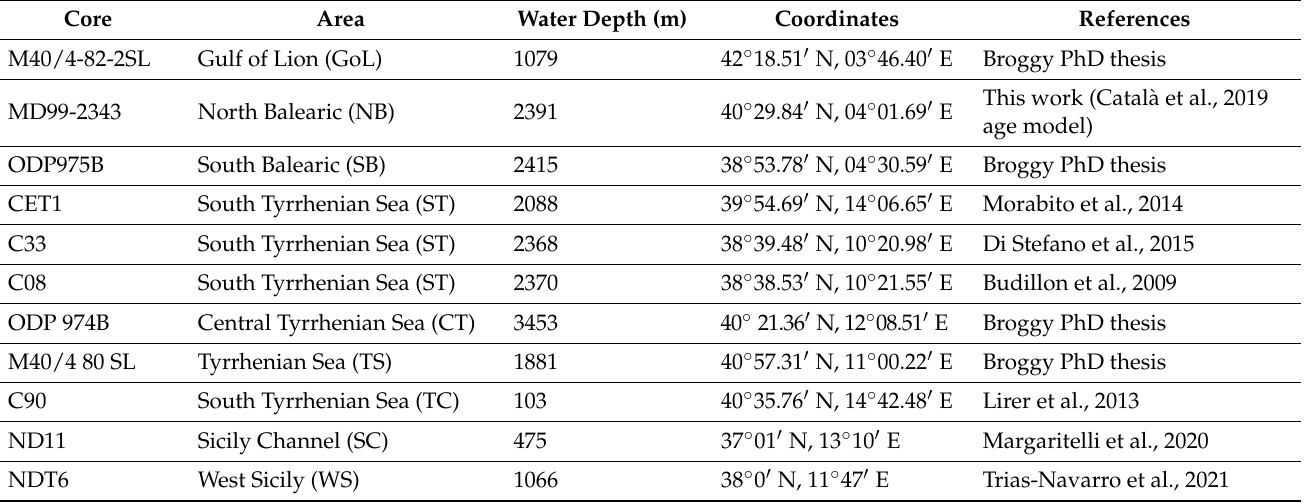
Table 1. Study sites, depths (meter water depth) and